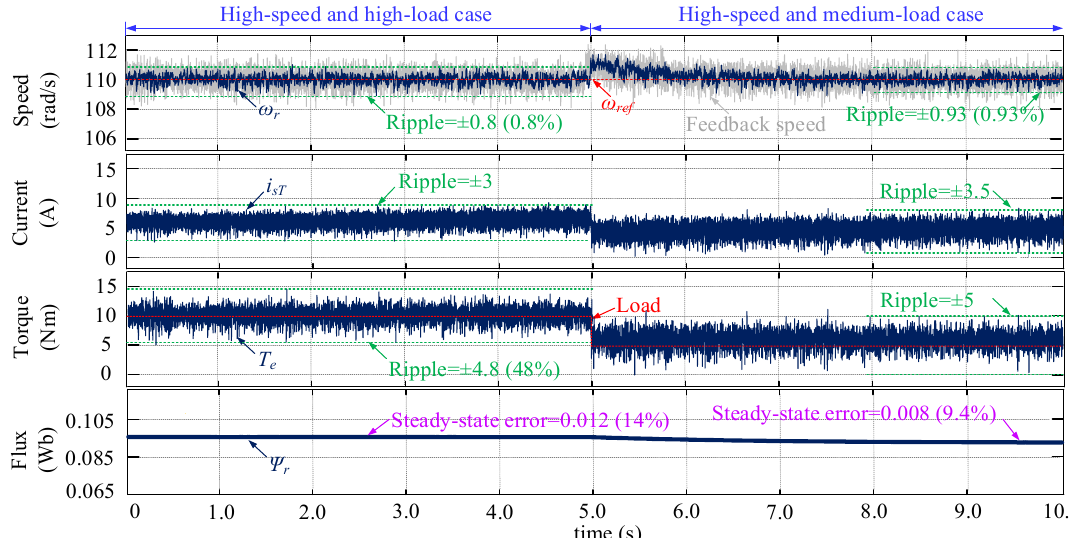
Figure 10. Performance of traditional FCS-MPTC with fixed PI parameters and fixed weighting factor.